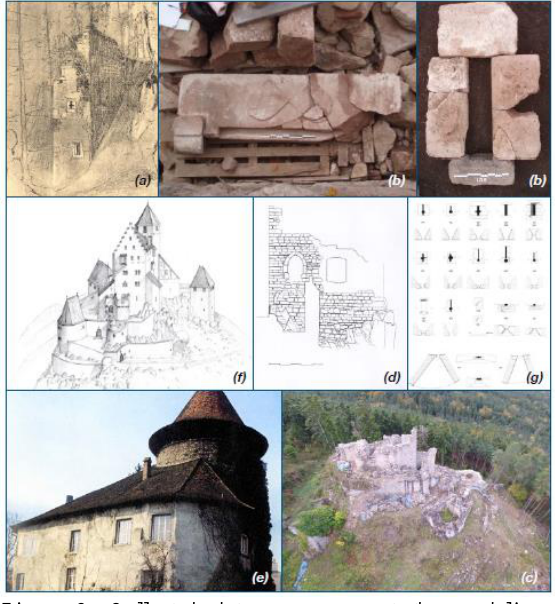
Figure 3: Collected data as a support the modeling